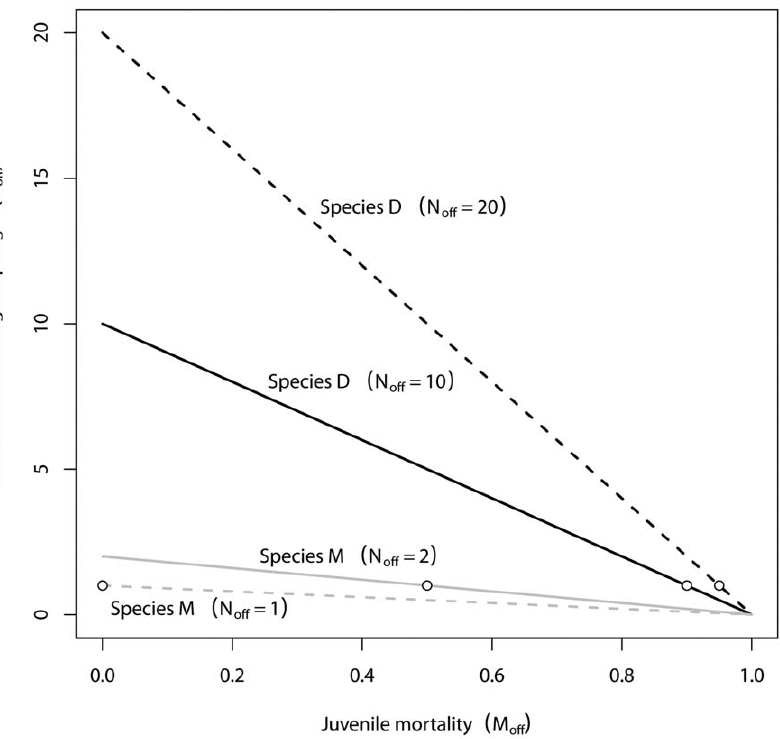
Figure 4. Numbers of surviving offspring (S off ) of species M (mammal-like) and D (dinosaur-like). S off is shown for different potential reproductive outputs (N off ) and different juvenile mortalities (M off ). Species D with the high reproductive output (N off =10, black solid line or N off =20, black scattered line) reacts more sensitively to changes in the juvenile mortality rate M off in terms of the number of surviving offspring (S off ) than species M with the lower reproductive output (N off =1, grey scattered line or N off =2, grey solid line). The slopes for M off against S off are much shallower for species M than for species D. The circles mark the (M off ,S off ) pairs for which S off equals one surviving offspring (for details see text).